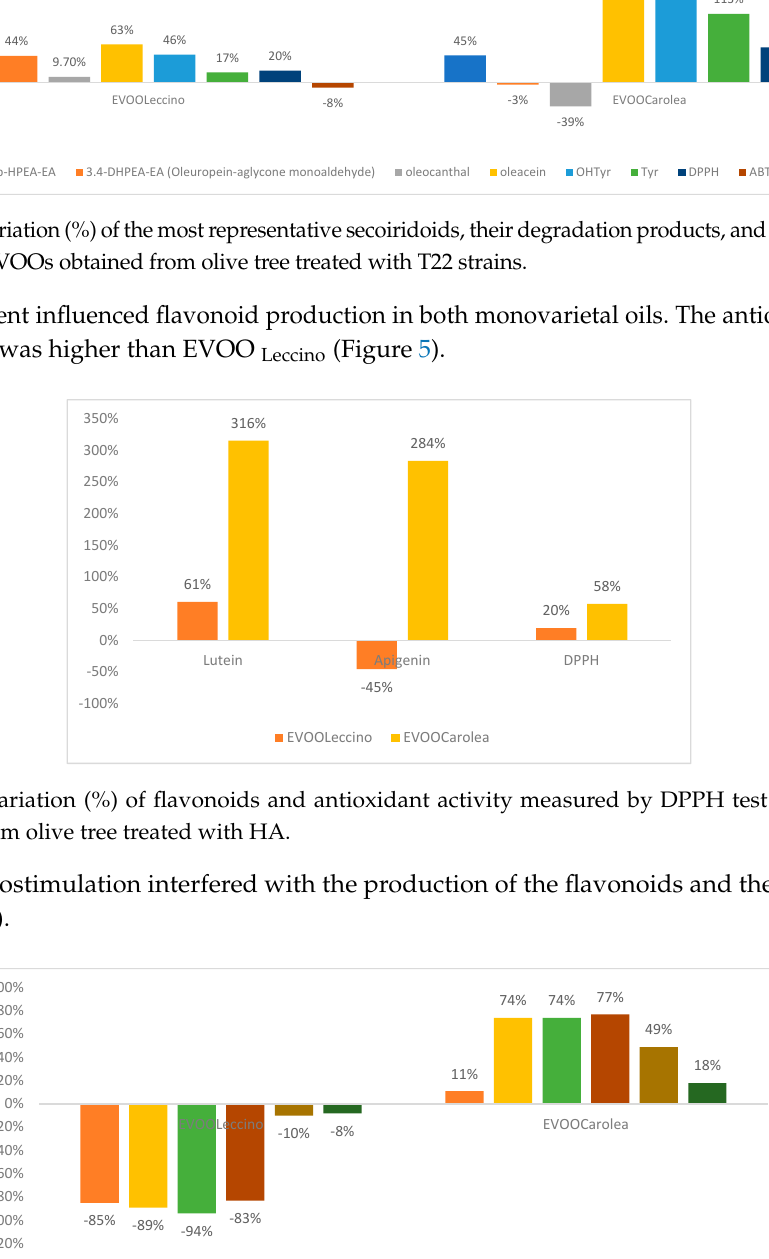
Figure 6. Variation (%) of flavonoids, lignans and antioxidant activity in the EVOO samples obtained from olive tree treated with 6PP. The total phenolic content was strongly affected by variations of the concentration of oleacein, tyrosol and apigenin (Figure 7).